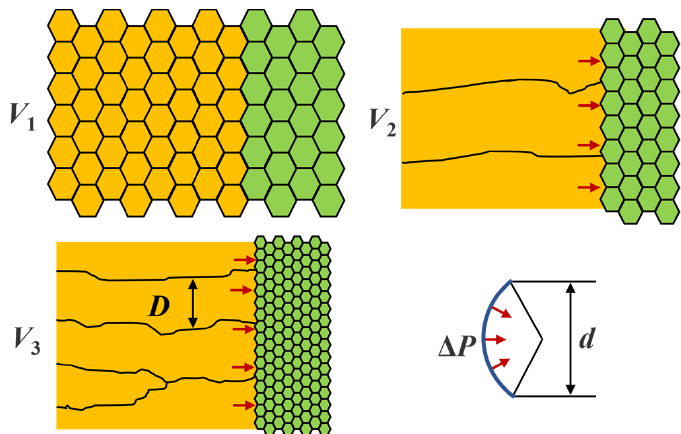
Figure 9. Schematic view of the columnar grain growth during the directional annealing, where V1 < V2 < V3, data from [15].